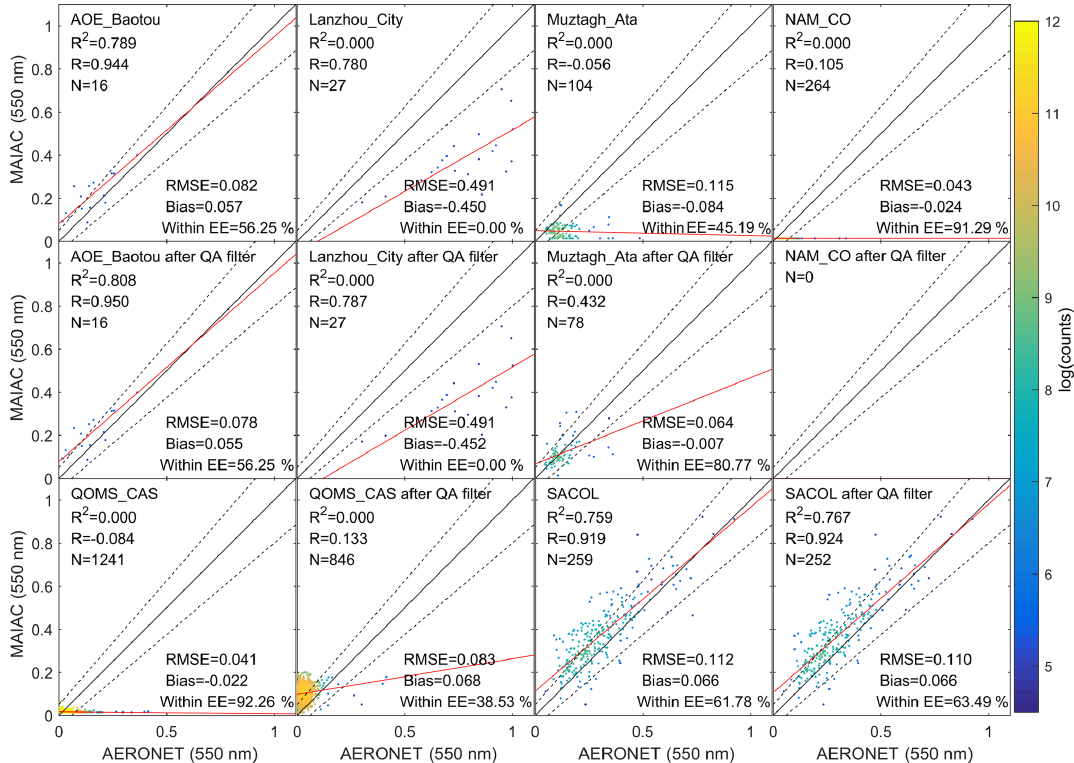
Figure 5. Evaluation of the MAIAC accuracy in the grassland area for each AERONET site before and after the QA filter. The black line, red line, and dashed line in the scatterplot are the 1:1 reference line, regression line, and expected error (EE = ± ( 0 . 05 + 0 . 15 × AOD ) ) line,